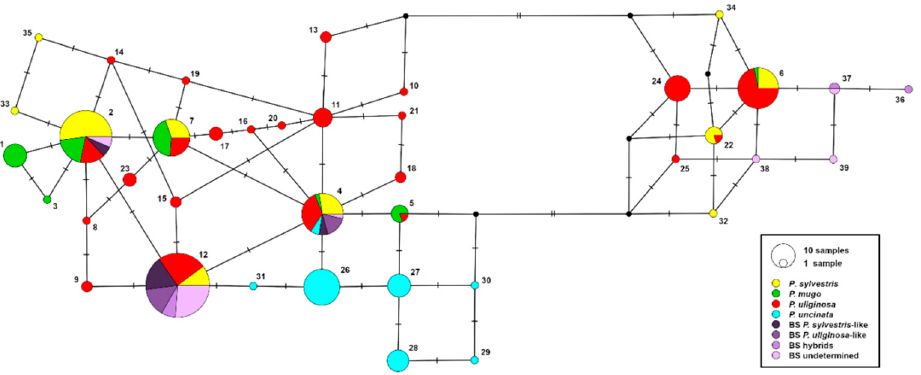
Figure 2. Median Joining network of the mitotypes of pines from the mixed population in Bł˛edne Skały (BS) and the reference four pine species populations based on 14 mtDNA regions. Circle sizes represent relative frequencies of haplotypes in a combined sample, lines between two circles represent singular mutation events, and black dots substitute absent haplotypes (population acronyms as in Table 1).